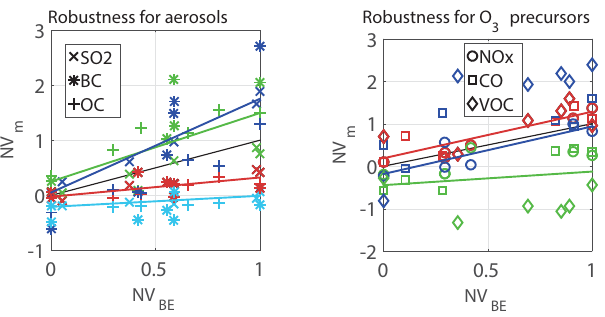
Figure 4. Scatter plot of the normalized variability of the model estimates (NV m ) versus NV BE for the best estimate. Colors of the symbols indicate individual models (red: OsloCTM2; green: NorESM; blue: HadGEM3; and light blue: ECHAM6) and the shape of the symbol indicate individual species. Left panel: aerosols and aerosol precursors (BC, OC, and SO 2 ) . Right panel: ozone pre- cursors (NO x , CO, and VOCs). The black line is the one-to-one line. The estimates use the GTP(20) emission metric.